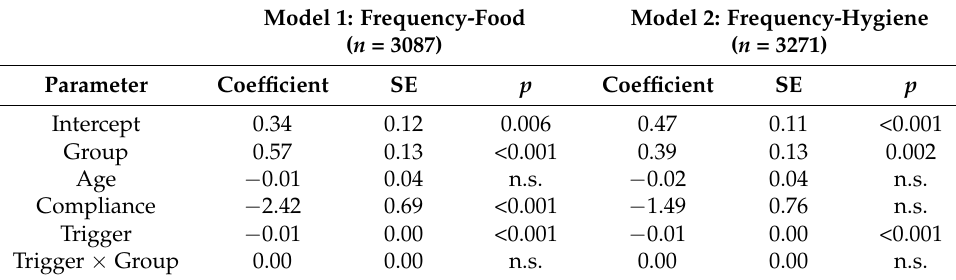
Table 2. Multilevel estimates for models predicting habit occurrence. Model 1: